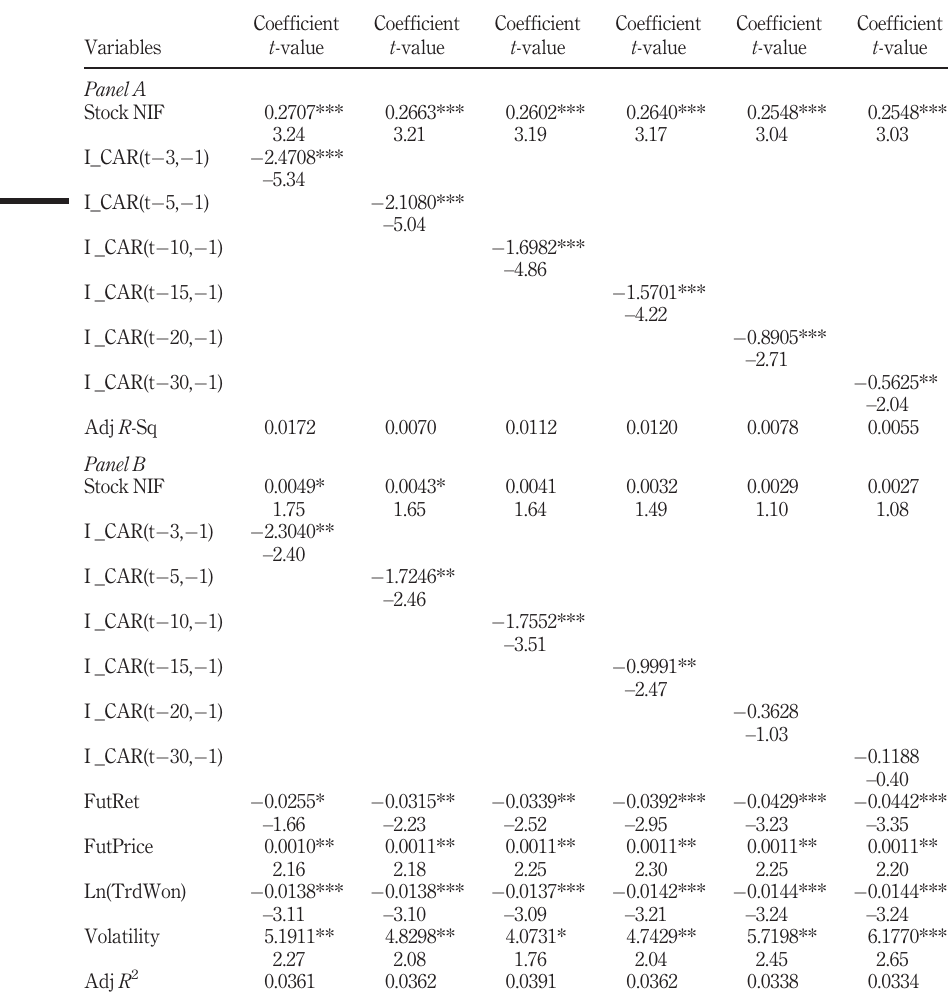
Table 6. Effect of the NPS ’